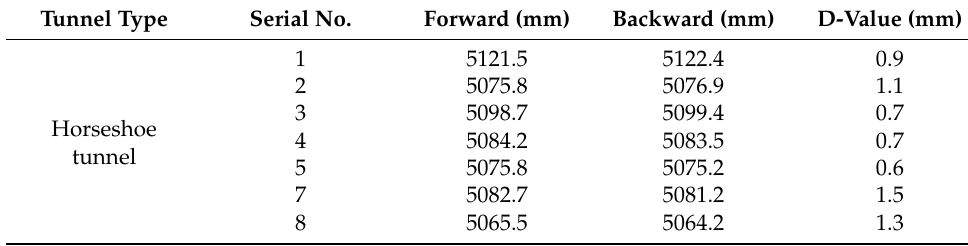
Table 4. Comparison of vault net height accuracy of roundtrip